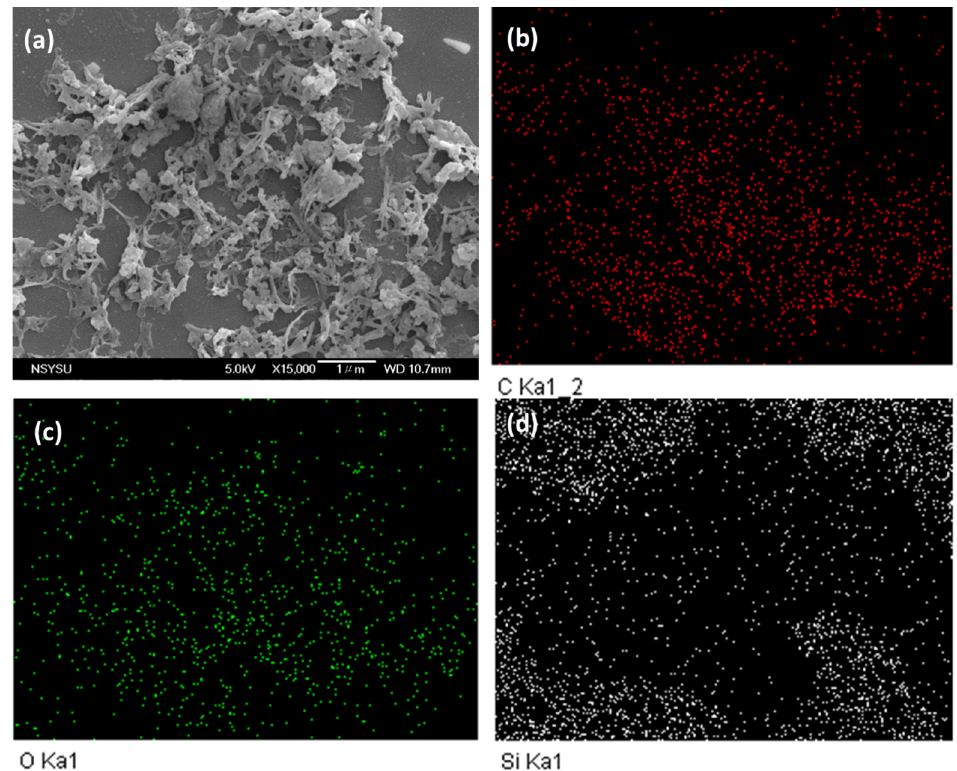
Figure 6. SEM images and their corresponding element mapping for ( a – d ) OVS-P-A HPP.